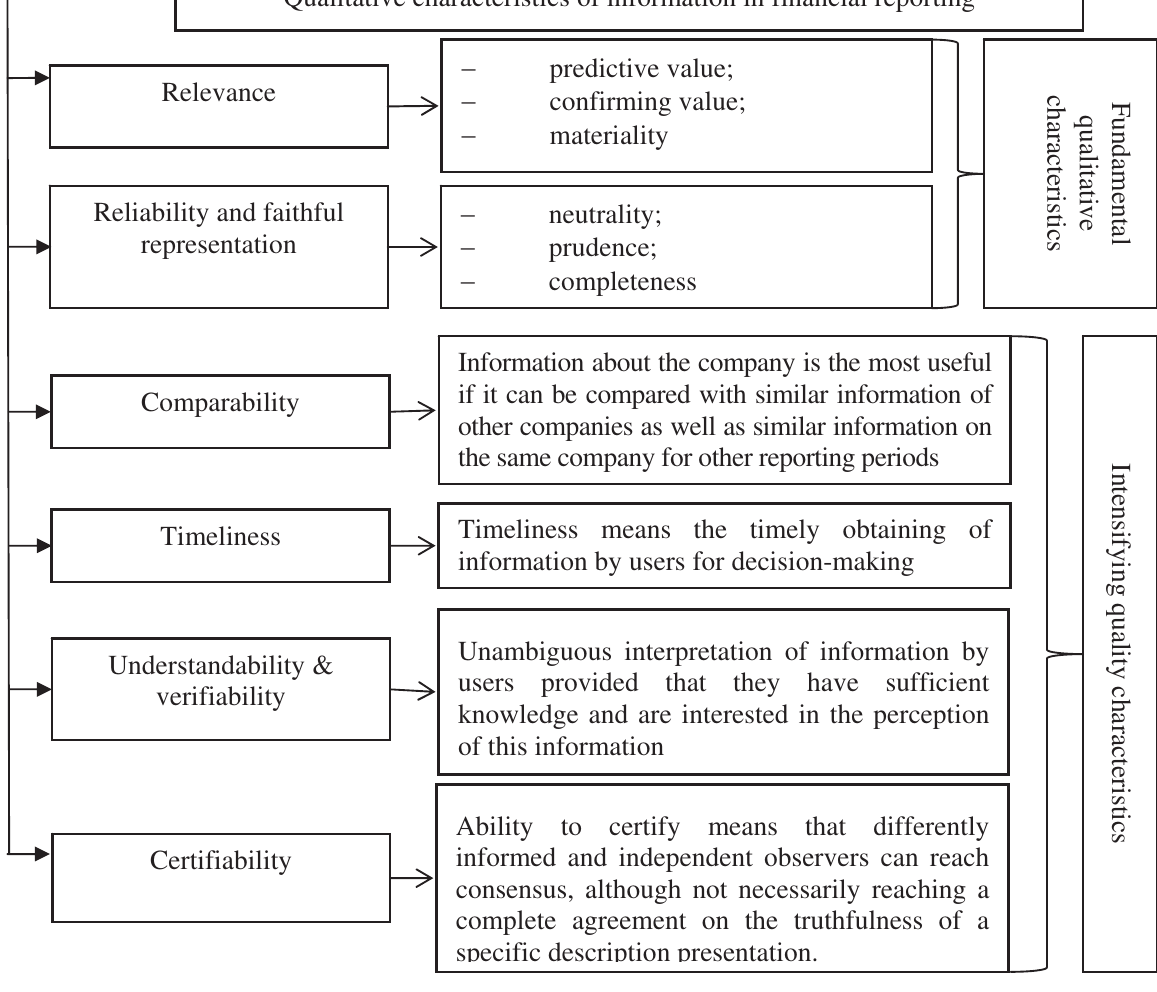
Fig. 1. Quality requirements to financial reporting (Conceptual Framework for Financial Reporting, 2014)